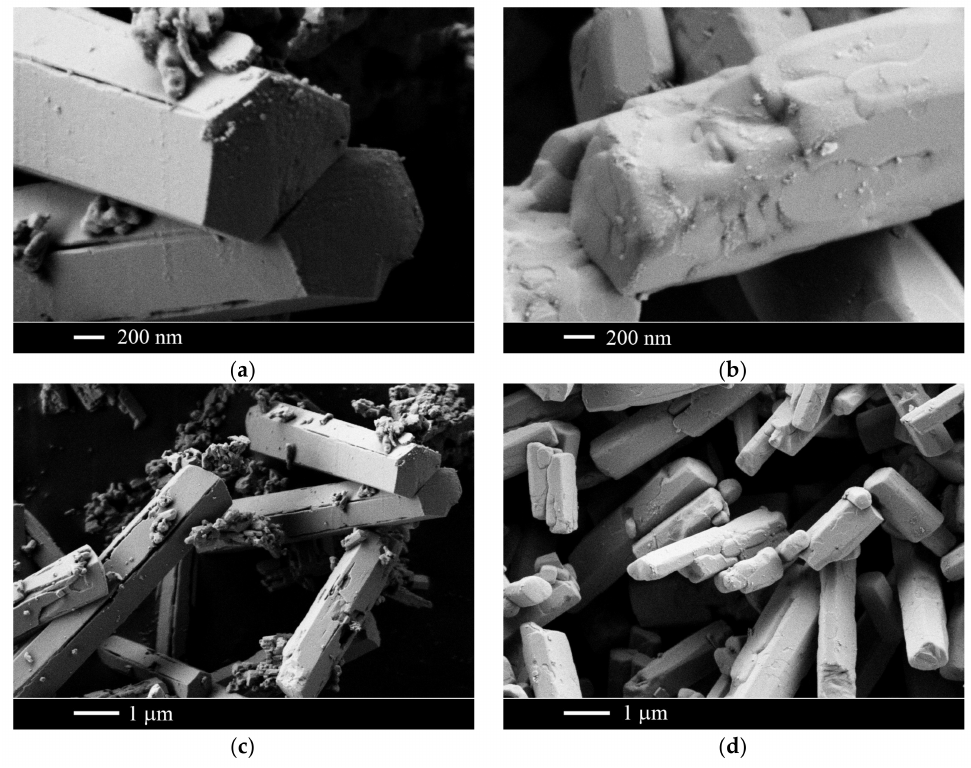
Figure 4. SEM images of NaYF 4 specimens (synthesized at ratios of Y(NO 3 ) 3 :NaF:NaNO 3 starting materials equal to 7:52:41) synthesized at 320 ◦ C ( a , c ) (sample 3); 435 ◦ C ( b , d ) (sample